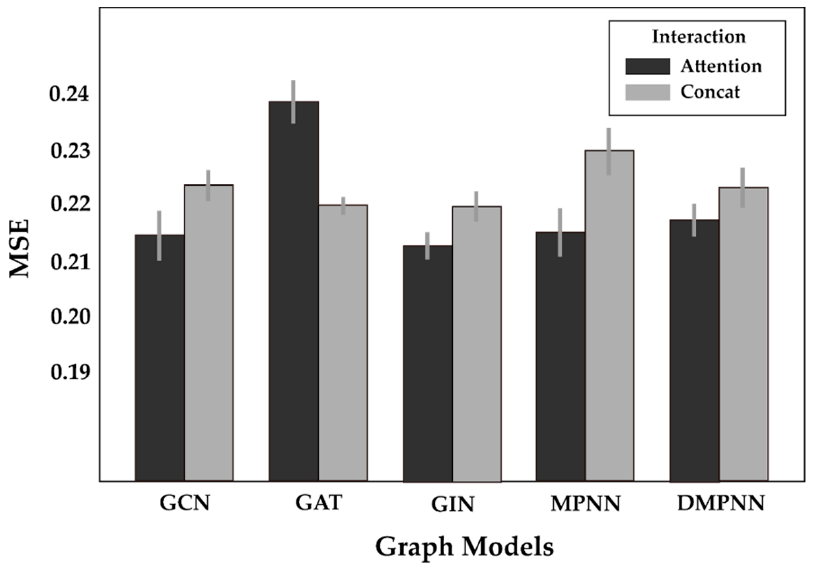
Figure 4. Ablation study on the Davis dataset.